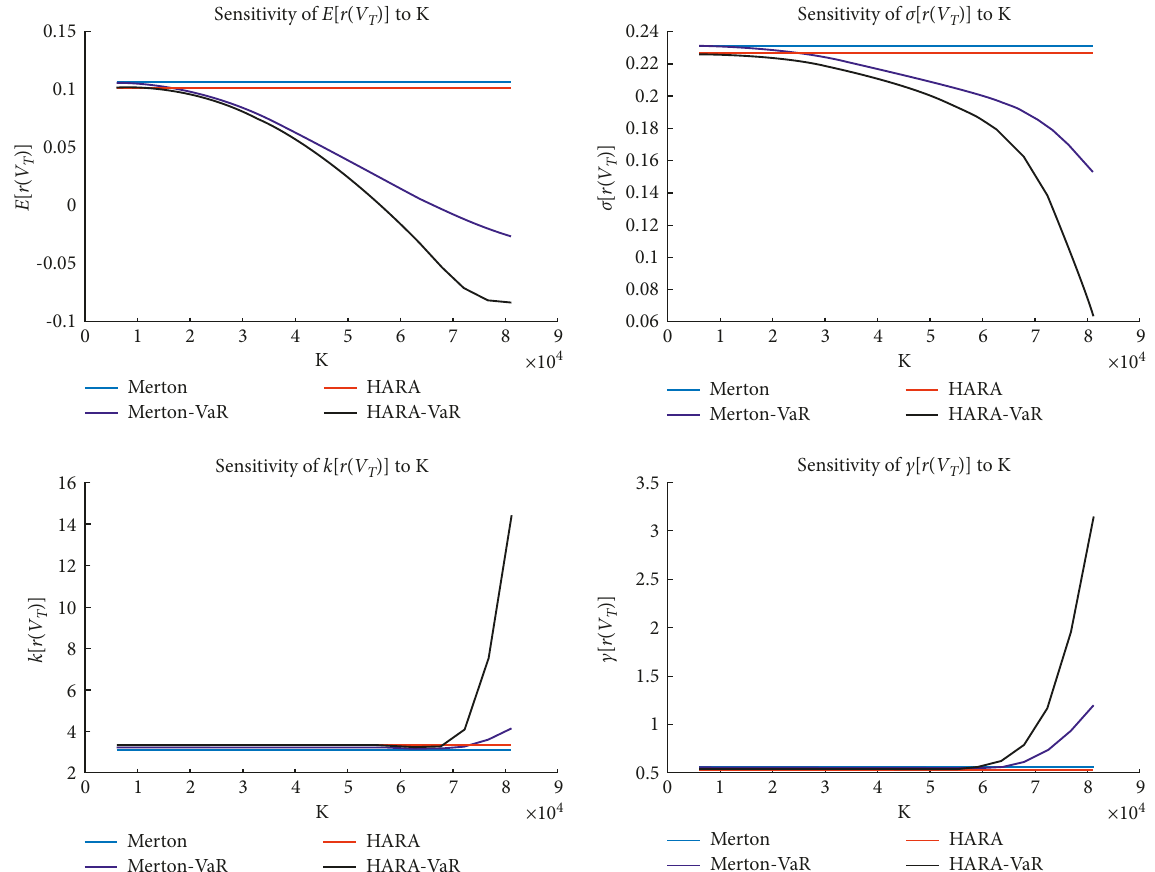
Figure 3: First four moments of sensitivity to K for Merton (Power), Merton-VaR (Power-VaR), HARA, and